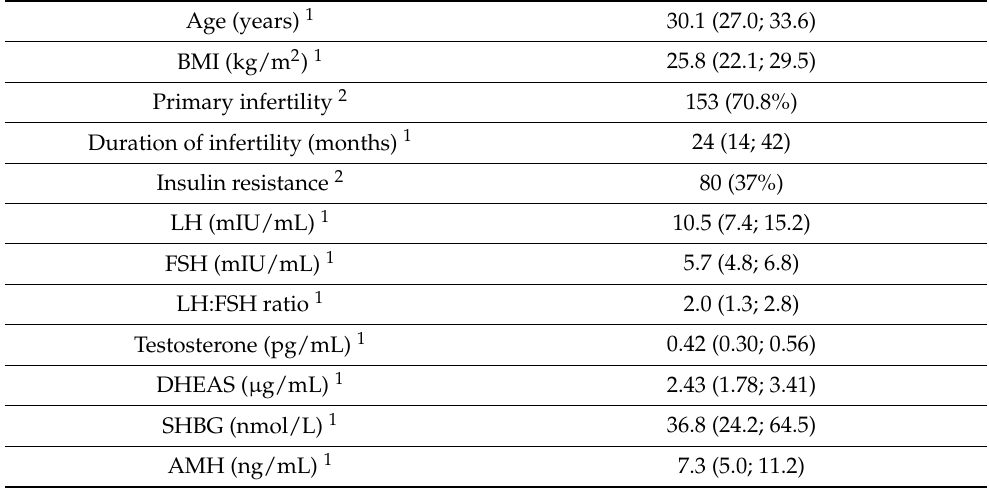
Table 1. Core patient characteristics and results of hormonal testing.